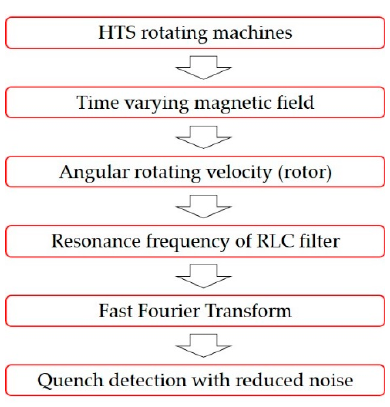
Figure 1. Flow chart of novel fault diagnosis method for superconducting rotating machine.